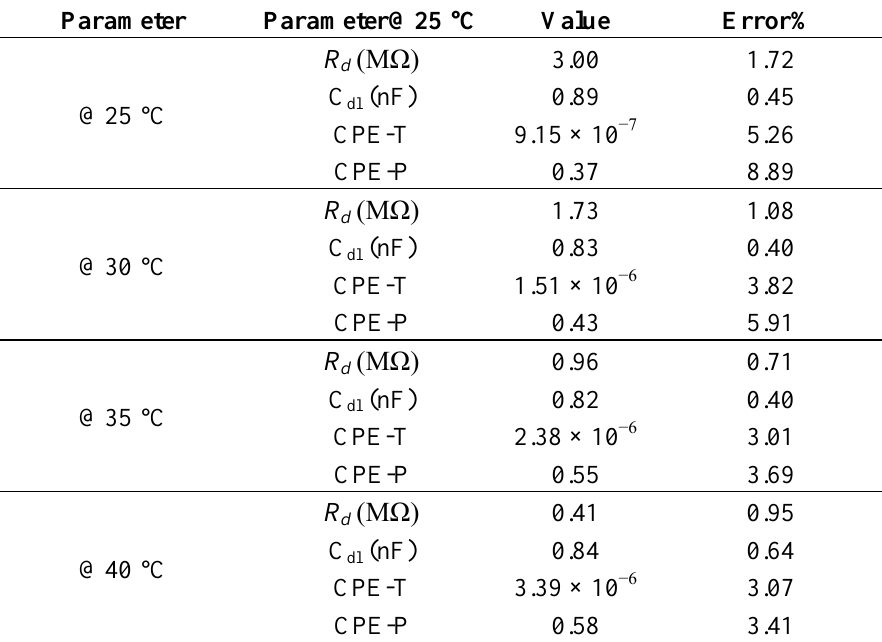
Table 2. Results of fitting in the temperature range of 25 to 40